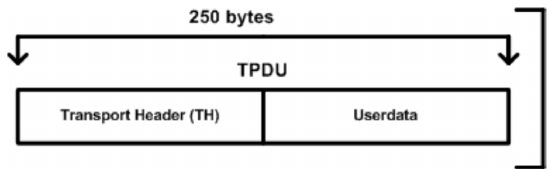
Figure 4. Single TPDU block.